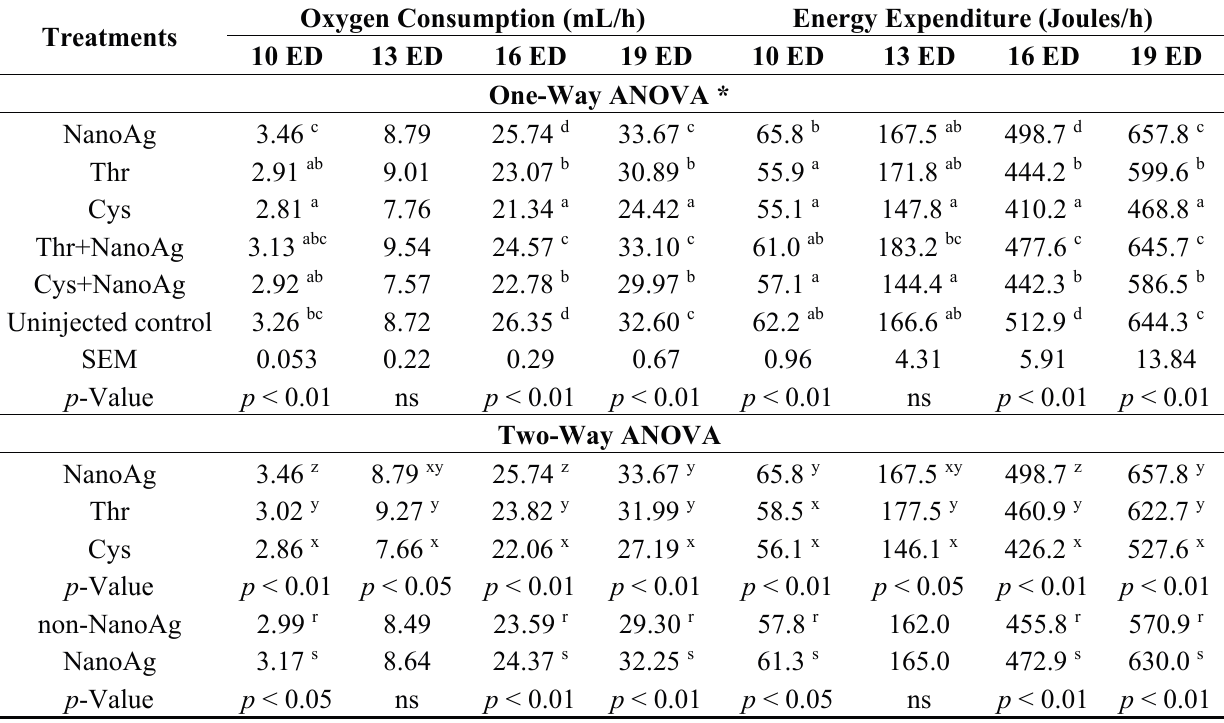
Table 3. Oxygen consumption and energy expenditure from chicken embryo during 10–19 days of embryogenesis (ED) in eggs injected with nanoparticles of silver (NanoAg), threonine (Thr), cysteine (Cys) and their combinations.